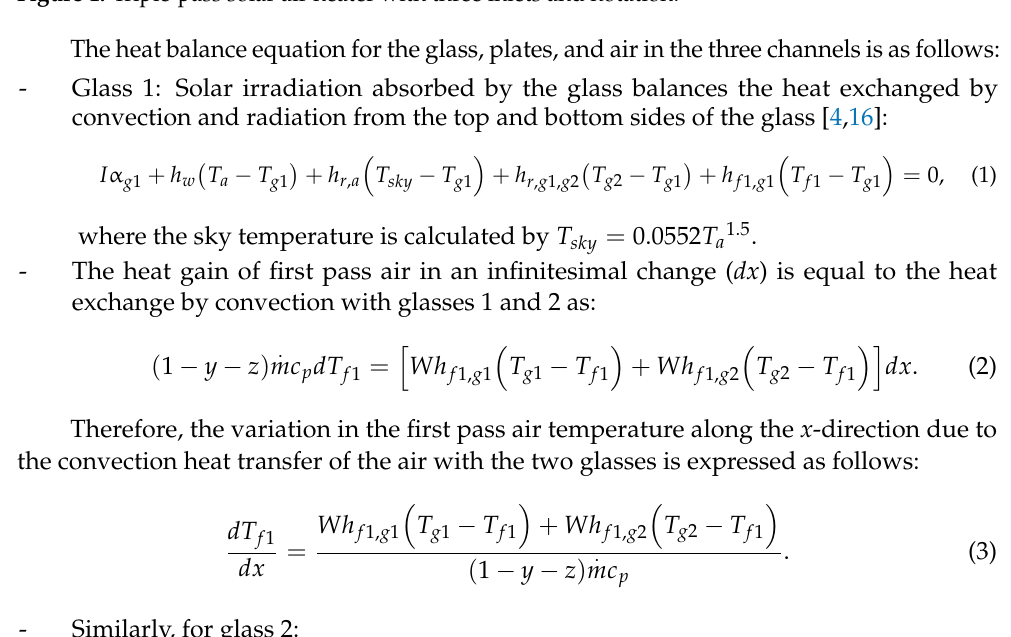
Figure 1. Triple-pass solar air heater with three inlets and notation.